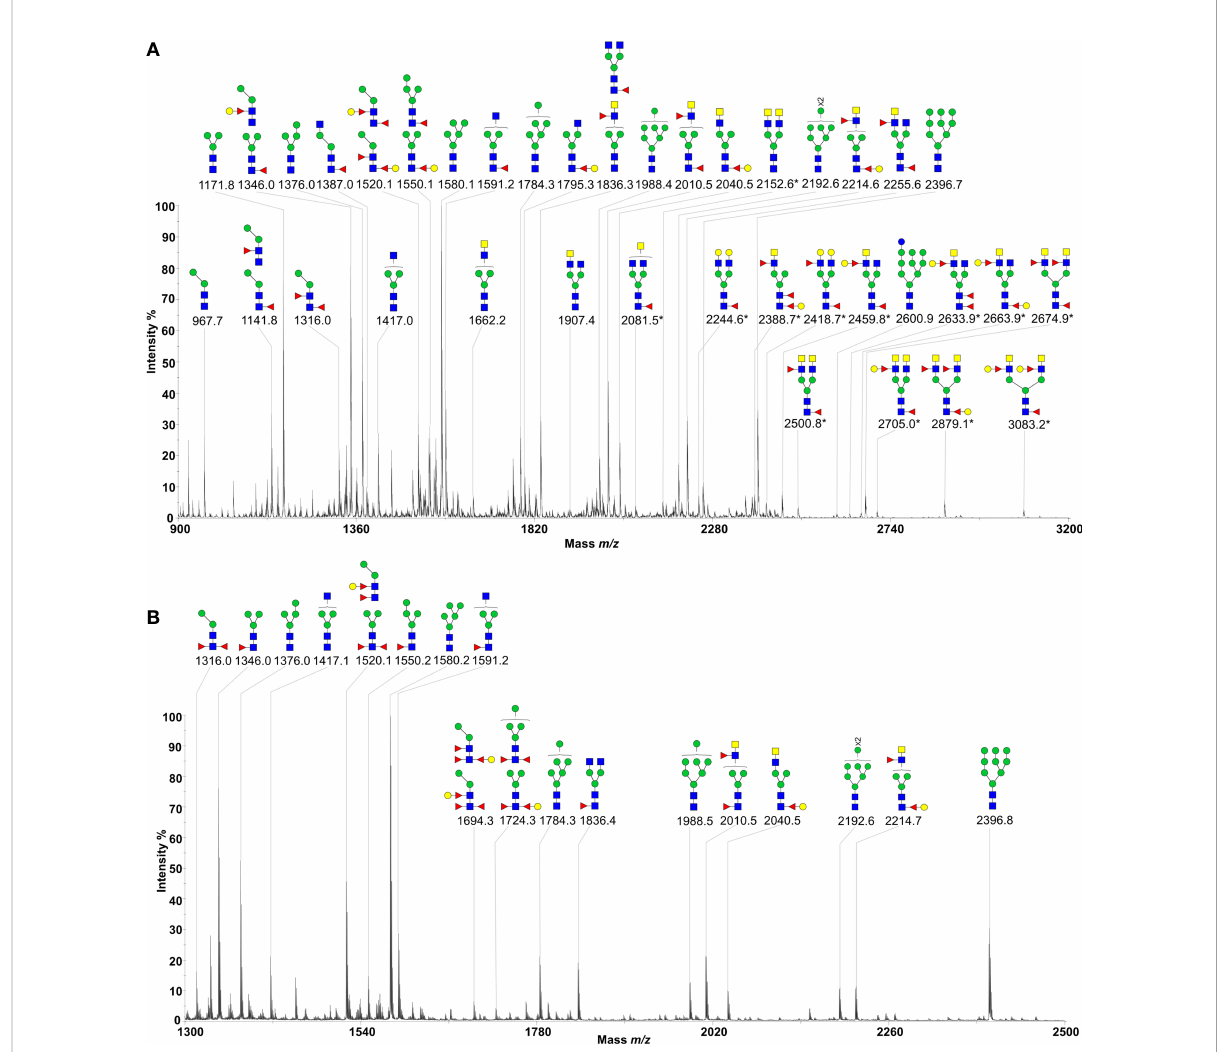
FIGURE 2 N-glycan pro fi les of Haemonchus contortus H11. H11 N-glycans were fully released by sequential digestion of glycopeptides with PNGase F and PNGase A. Two N-glycan pools were puri fi ed, permethylated and then subject to MALDI-TOF-MS analyses. (A) MALDI-TOF-MS spectrum of the permethylated N-glycans from H. contortus H11 released by PNGase F. The newly-found N-glycan signals are marked with asterisks (cf. Supplementary Table 3). (B) MALDI-TOF-MS spectrum of the permethylated N-glycans from H. contortus H11 released by PNGase A (cf. Supplementary Table 4). Glycan species are displayed primarily as [M + Na] + adducts. N-glycan peaks are annotated using the symbol nomenclature (green circle = mannose; yellow circle = galactose; blue circle = glucose; blue square = GlcNAc; yellow square = GalNAc; red triangle = fucose). All N-glycan structures are deduced by the MALDI-TOF-MS/MS fragmentation and the current knowledge of N-glycan biosynthesis in helminths (cf. Supplementary Tables 3,